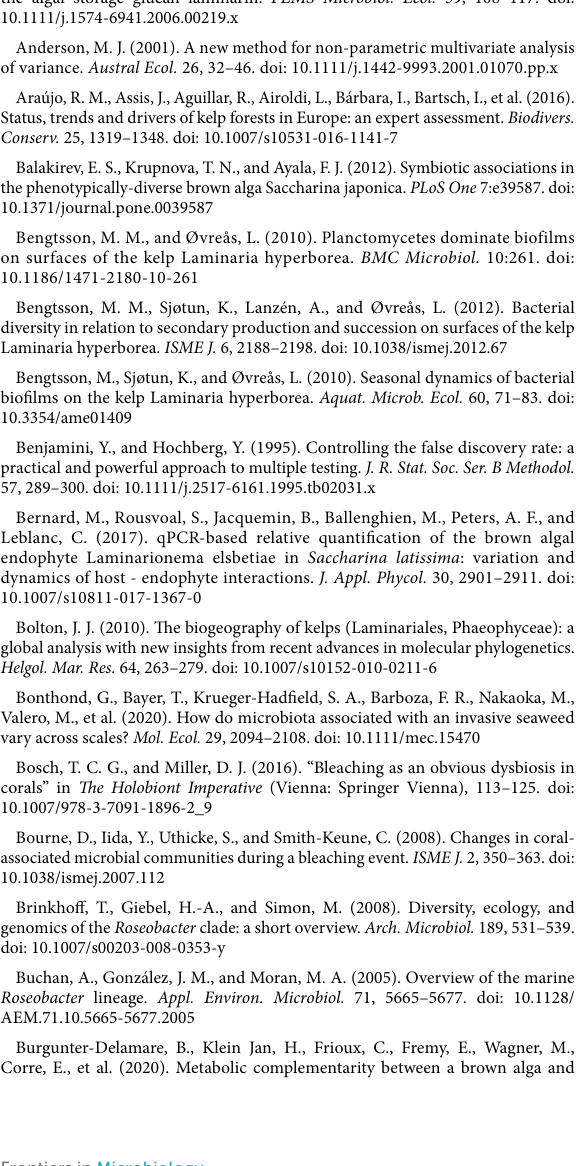
bold line: median value, dashed error bars: 1st and 9th deciles, red point: value for the selected year. SUPPLEMENTARY TABLE S1 Taxonomic affiliations of over-expressed ASVs for each comparison (algal part, regions, seasons, and